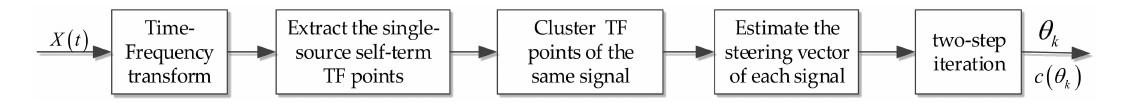
Figure 1. The flow diagram of the proposed